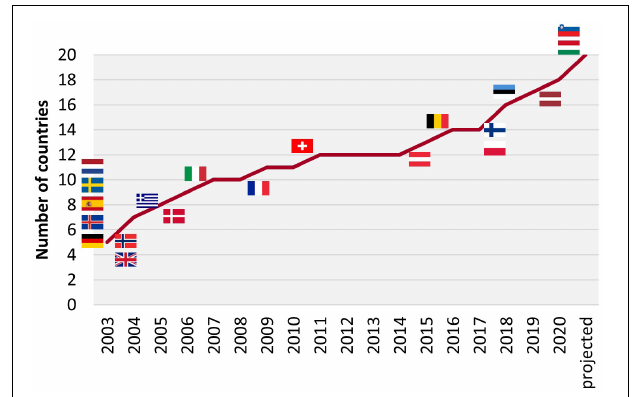
FIGURE 3 | Historical development of the involvement of countries in Power-to-X projects.